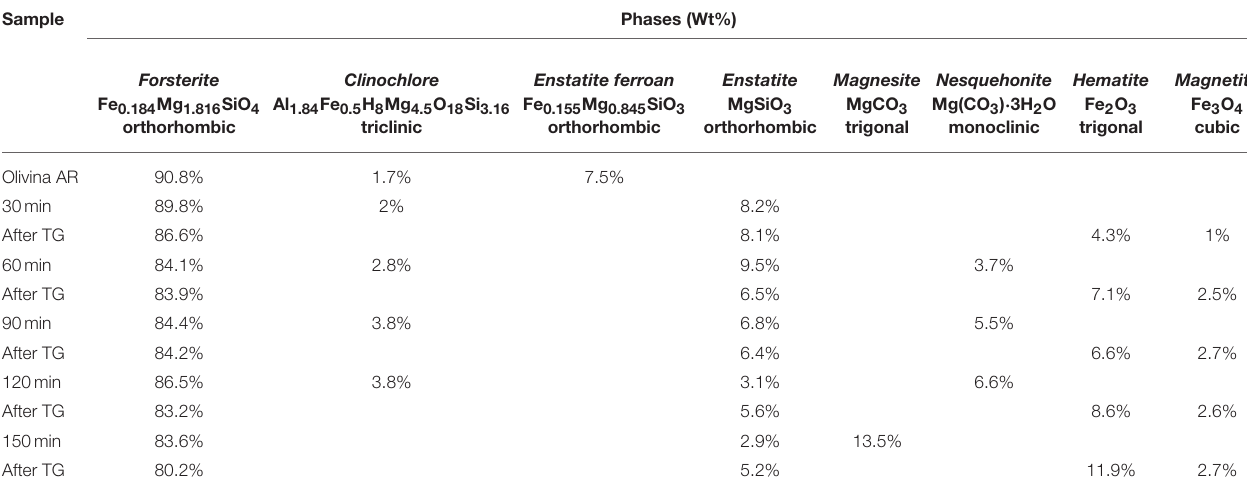
TABLE 4 | Phase composition, as evaluated by Rietveld analysis, of different samples after selected time of mechanical treatment, in the second series of tests, run under the initial CO 2 pressure of 1